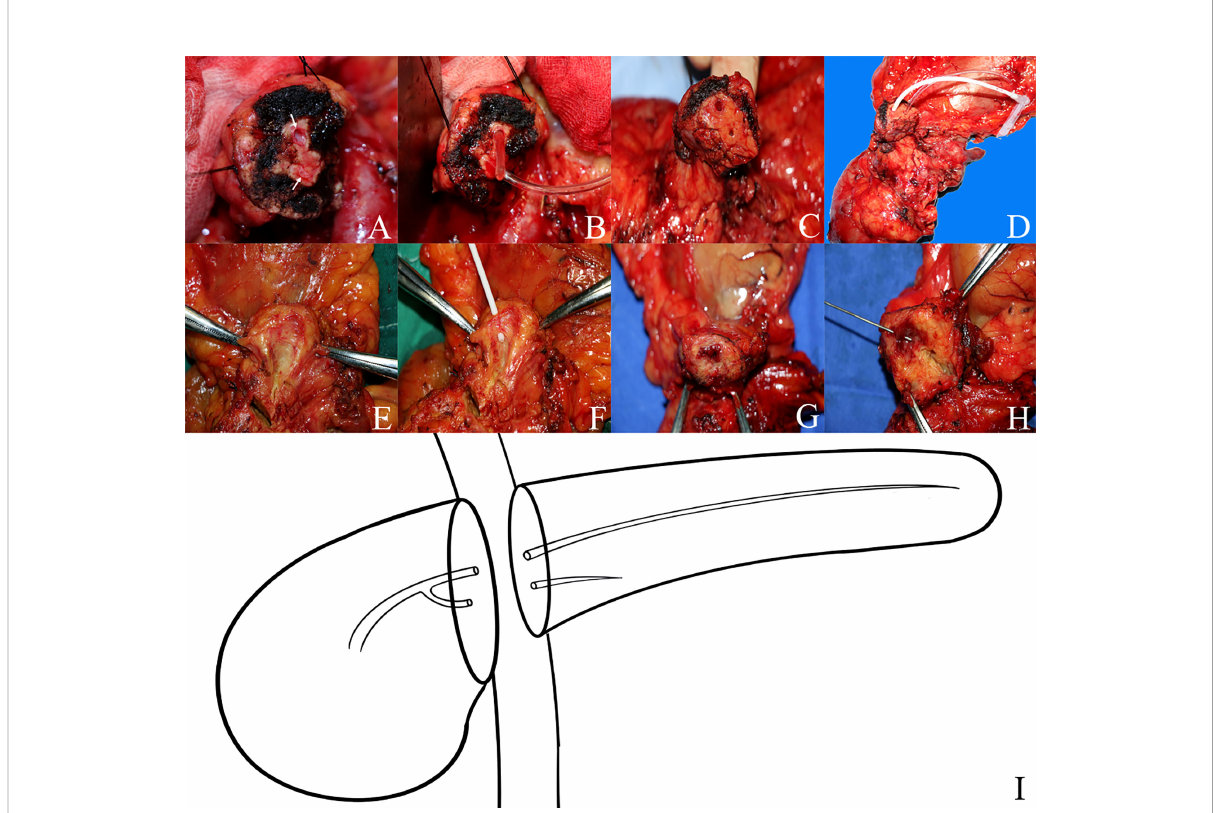
FIGURE 1 The anatomy of bi fi d pancreatic duct (A – D) Two pancreatic duct ori fi ces in the remnant pancreas body during pancreaticoduodenectomy and the bi fi d pancreatic duct anatomy were con fi rmed via intraoperative probing and direct visualization of the ductal ori fi ces. (E – H) The bi fi d pancreatic duct anatomy was con fi rmed by dissecting the resected specimen postoperatively; the bi fi d pancreatic duct in the body of the pancreas joins at the pancreatic head and drains through the major papilla. (I) Diagram of the anatomy of bi fi d pancreatic